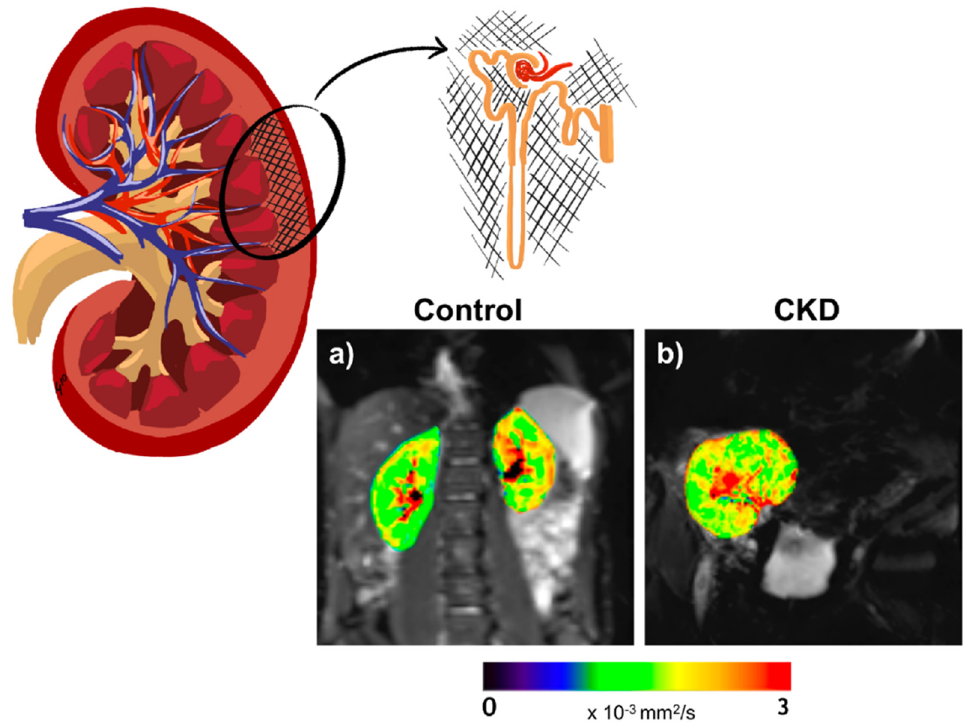
Figure 3. Representative ADC maps in a healthy volunteer (age 28 years) ( a ) and an individual with kidney transplant and CKD (age 69 years, eGFR 62 mL/min/1.73 m 2 ) ( b ). The color bar applies for both control and CKD. ADC maps of the kidneys are overlaid on the diffusion image with gradient b = 0.